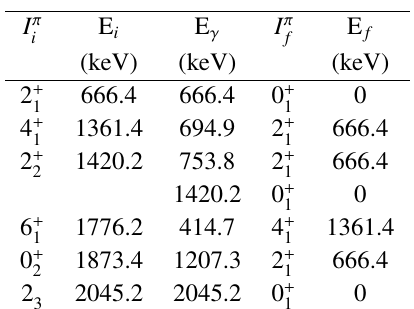
Table 3. Observed transitions in 126 Te. Level energies, spins and parities taken from Ref. [27].